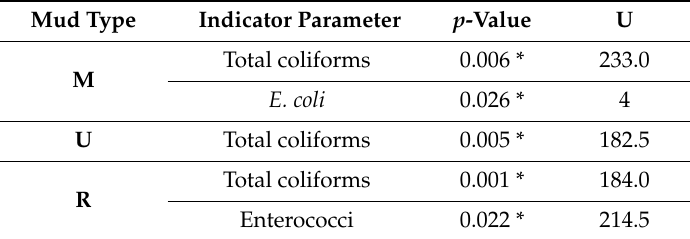
Table 10. Mann–Whitney U test for indicator parameter presence / absence in mud samples. p -values and U statistics are reported for the Mann–Whitney U test. All p -values are significant ( < 0.05) and thus are marked with asterisk (*). M—maturing mud, P—peloid, R—regenerating used mud.